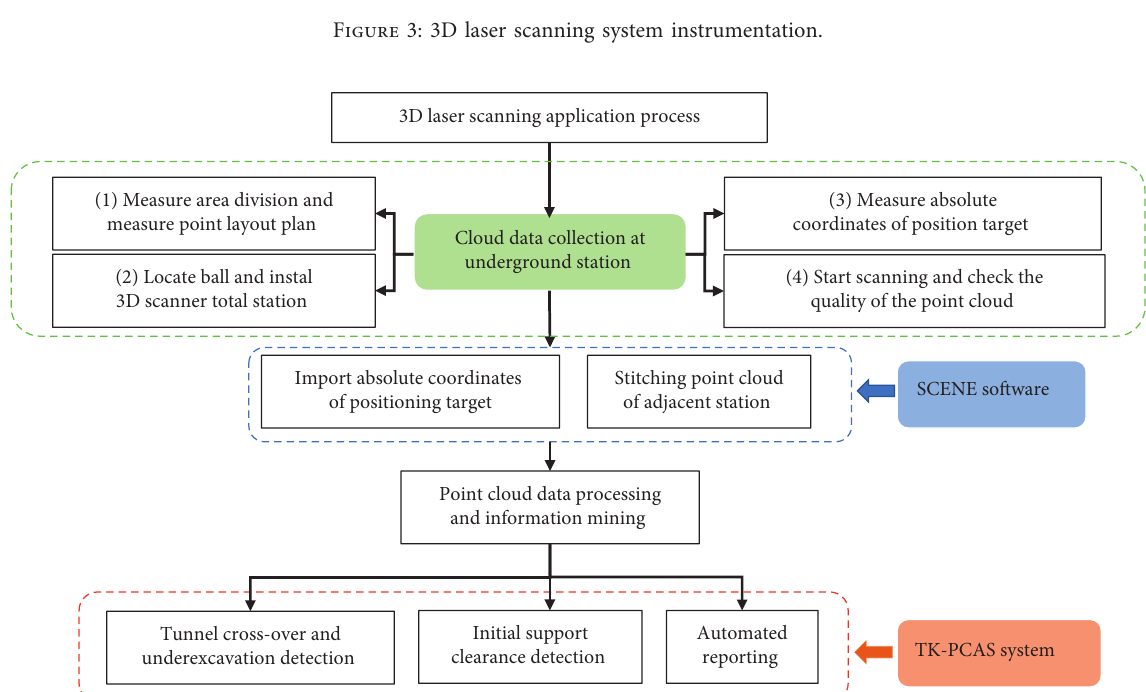
Figure 4: 3D scanner scanning application flow.